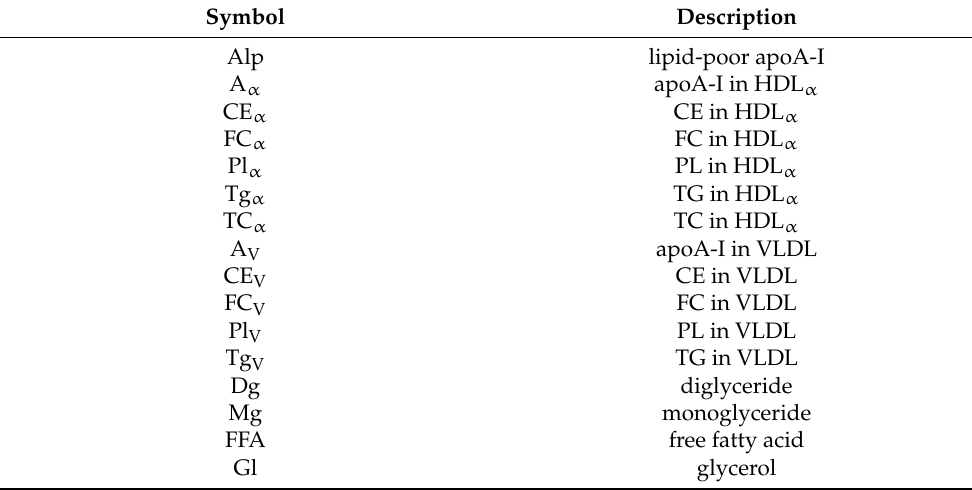
Table 1. Lipoprotein components included in the model. Symbol